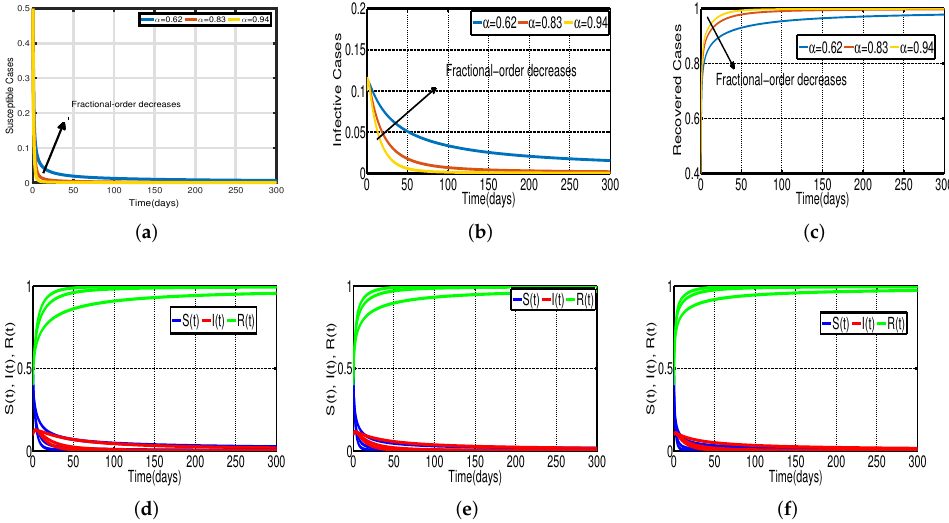
Figure 3. Vaccination model (2) without time delay. ( a ) Susceptible S ( t ) . ( b ) Infected I ( t ) . ( c ) Recov- ered R ( t ) . ( d ) Vaccination rate of 0.5%. ( e ) Vaccination rate of 0.8%. ( f ) Vaccination rate of 1.2%.